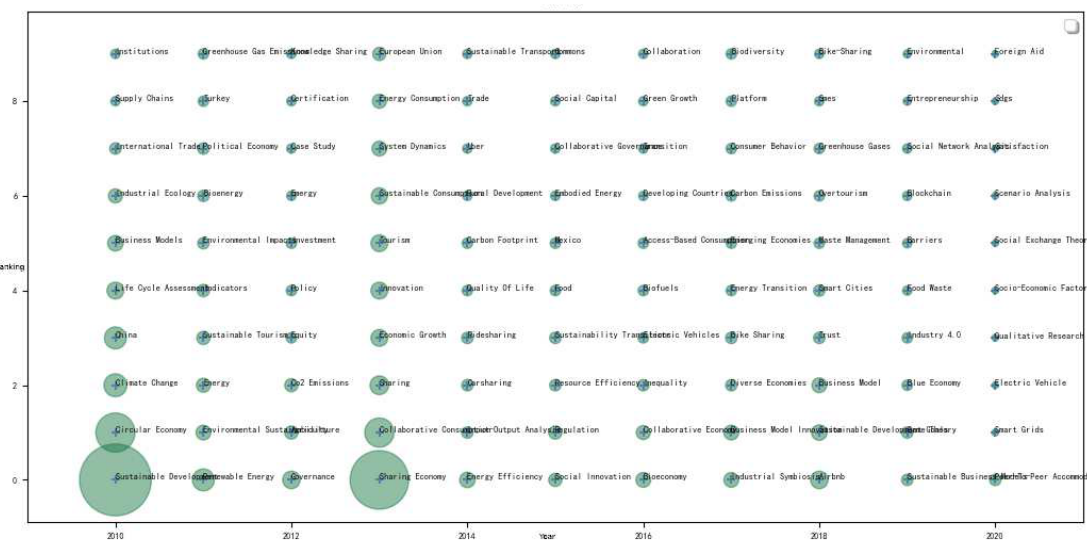
Figure 9. Cumulative Timezone view of the top 10 keywords on sustainable development in the sharing economy in each year from 2010 to